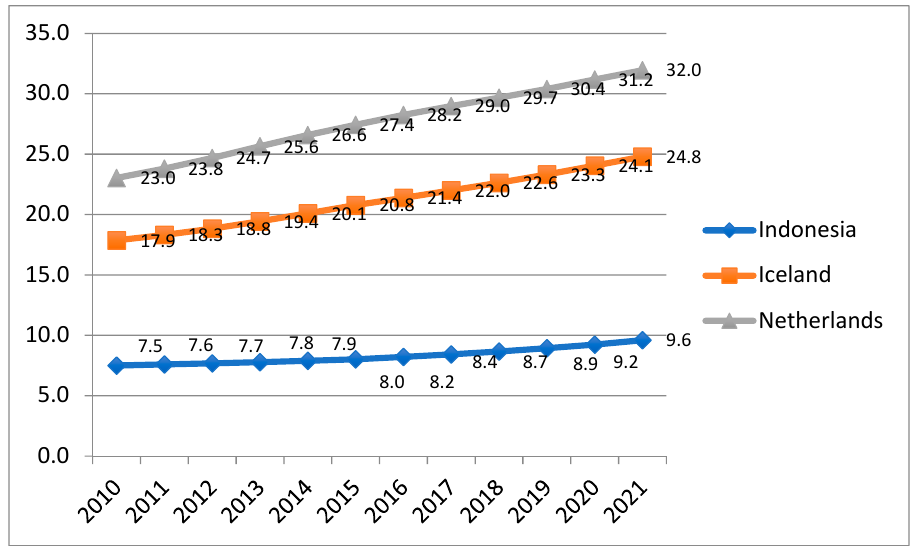
Scheme 3. Old-age dependency ratio in Iceland, the Netherlands, and Indonesia. Source: The World Bank (2022).